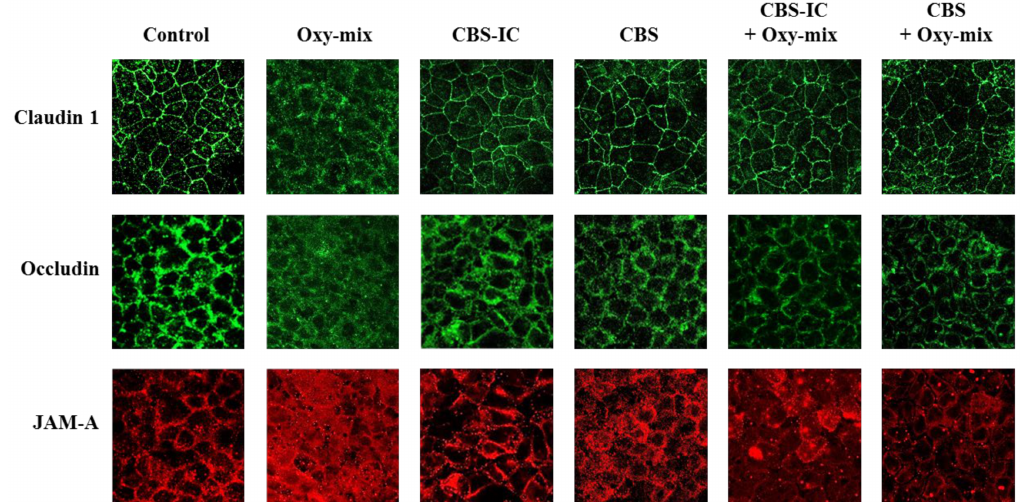
Figure 3. CBS formulations prevented TJ delocalization observed in oxysterol-treated CaCo-2 cell monolayers. A marked redistribution of claudin 1, occludin, and JAM-A after cell monolayer incubation with 60 µ M Oxy-mix for 24 h was visualized by immunofluorescence microscopy. CBS-IC or CBS pretreatments restored cellular localization, particularly claudin 1 and occludin. Claudin 1 and occludin images were immunostained with green color, whereas red color was used for JAM-A immunostaining (see Materials and Methods). Original magnification: ×